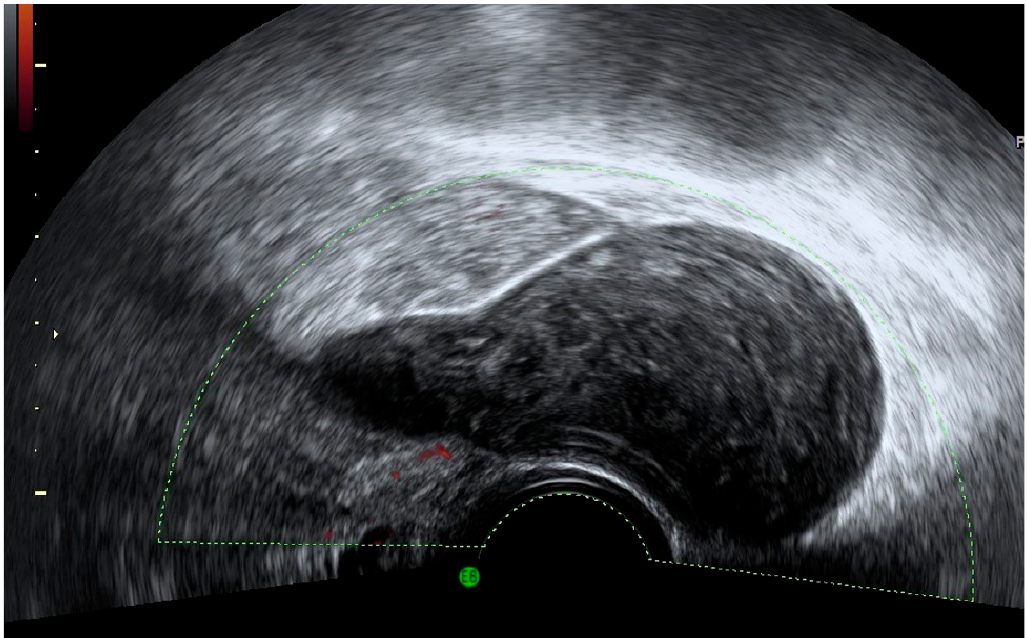
Figure 5. Power Doppler transvaginal ultrasound shows an appendiceal mucocele as a well-defined, thin-walled cystic mass with pear-shaped morphology with echogenic content and no vascularization.